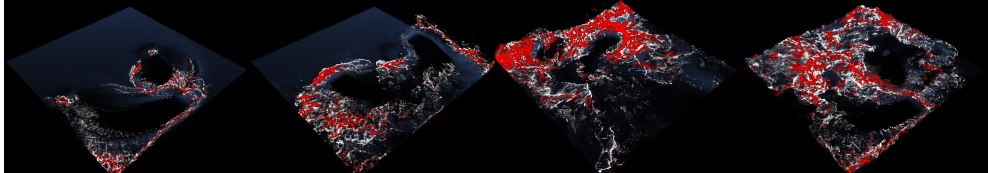
Figure 15. Motion difference with (white) or without (red) angular momentum-based advection. The related video has been submitted as Supplementary